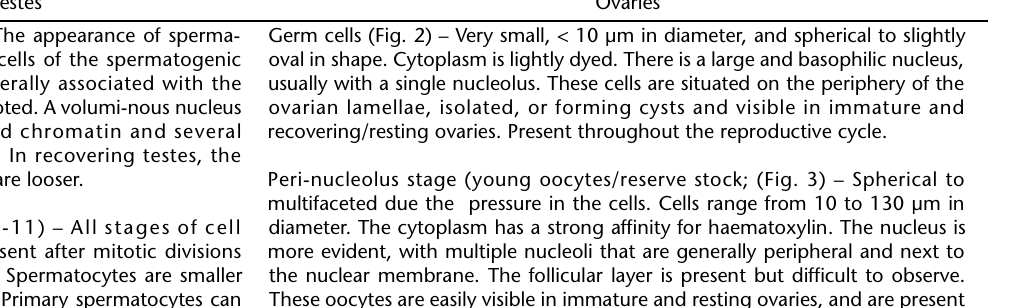
Table II. Microscopic description of gametogenesis in M. liza from the Sepetiba Bay. Testes Ovaries